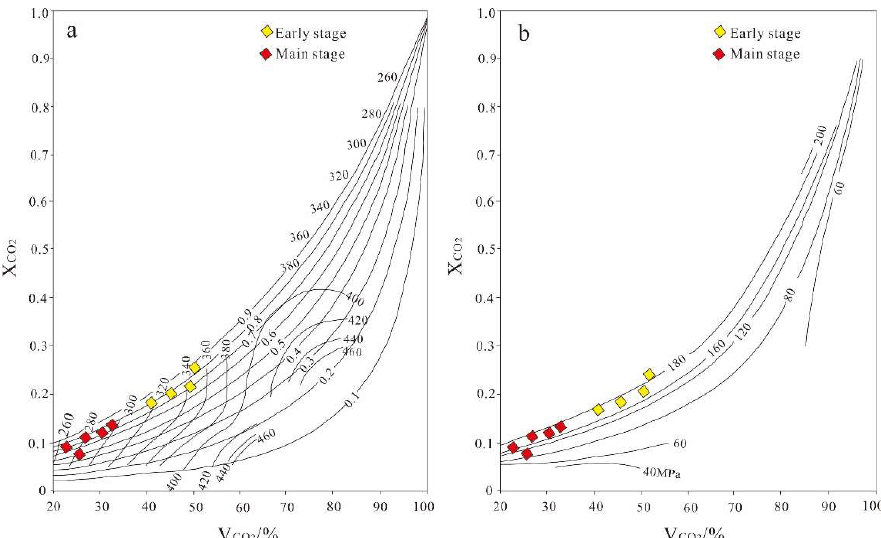
Figure 12. ( a ) Relationship of X CO2 , V CO2 , and CO 2 density, to Th TOT of the CO 2 –H 2 O–NaCl fluid inclusions with salinity of 6.0 wt % NaCl eqv. [109]. ( b ) Relationship of X CO2 , V CO2 to pressure of the inclusions with salinity of 6.0 wt % NaCl eqv. [108].